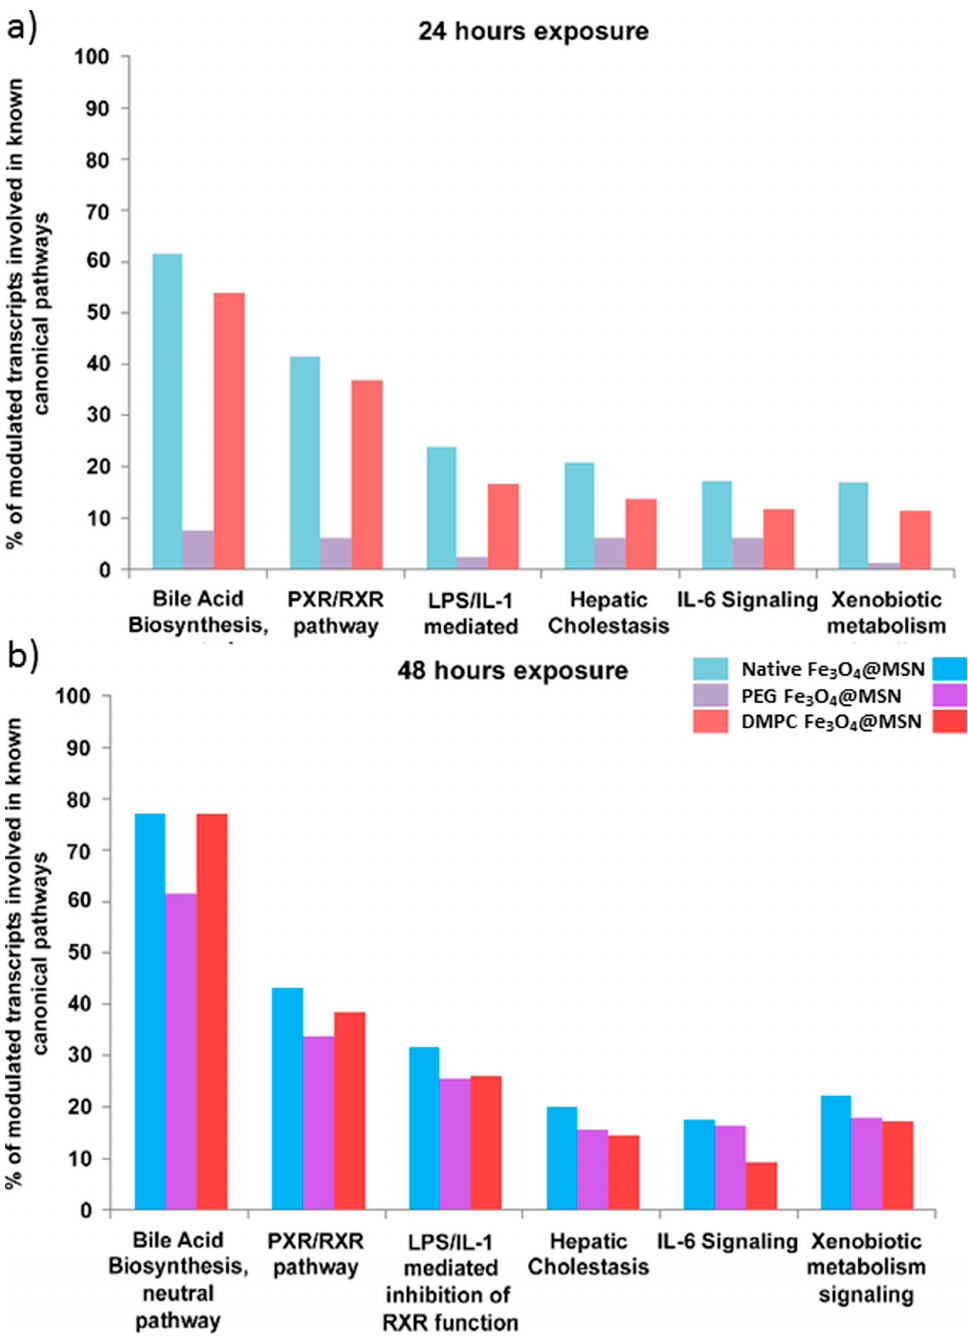
Figure 9. Canonical pathways elicited by each Fe 3 O 4 @MSN (80 mg cm − 2 ). The percentage of modulated transcripts of our datasets belonging to six major altered canonical pathways after ( a ) 24 and ( b ) 48 h exposure to Fe 3 O 4 @MSN. These pathways were all significant according to a Fisher’s